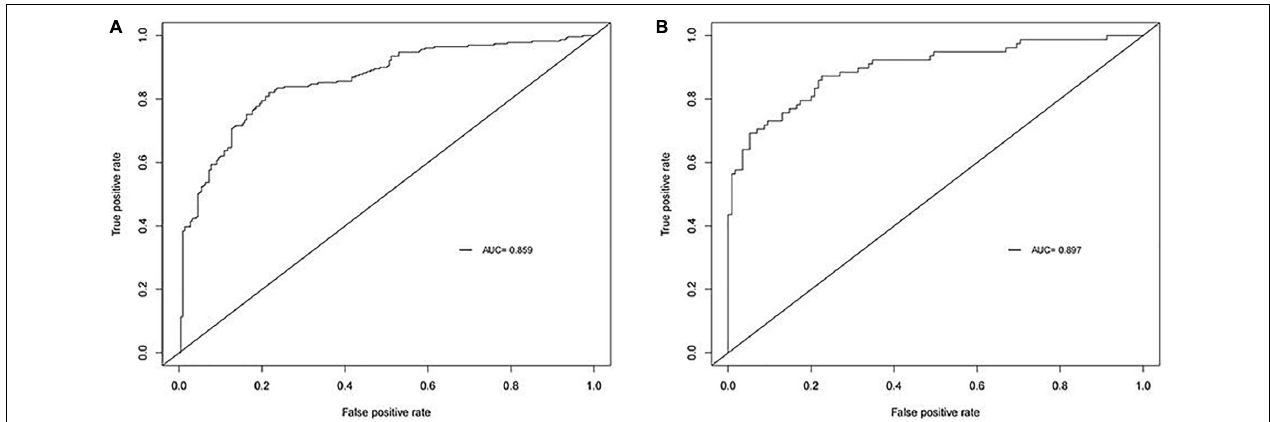
FIGURE 1 | Receiver operating characteristic curve (ROC) of our model. The area under curves (AUC)are 0.859 and 0.897 in training cohort and validation cohort respectively. (A) Training cohort. (B) Validation cohort.